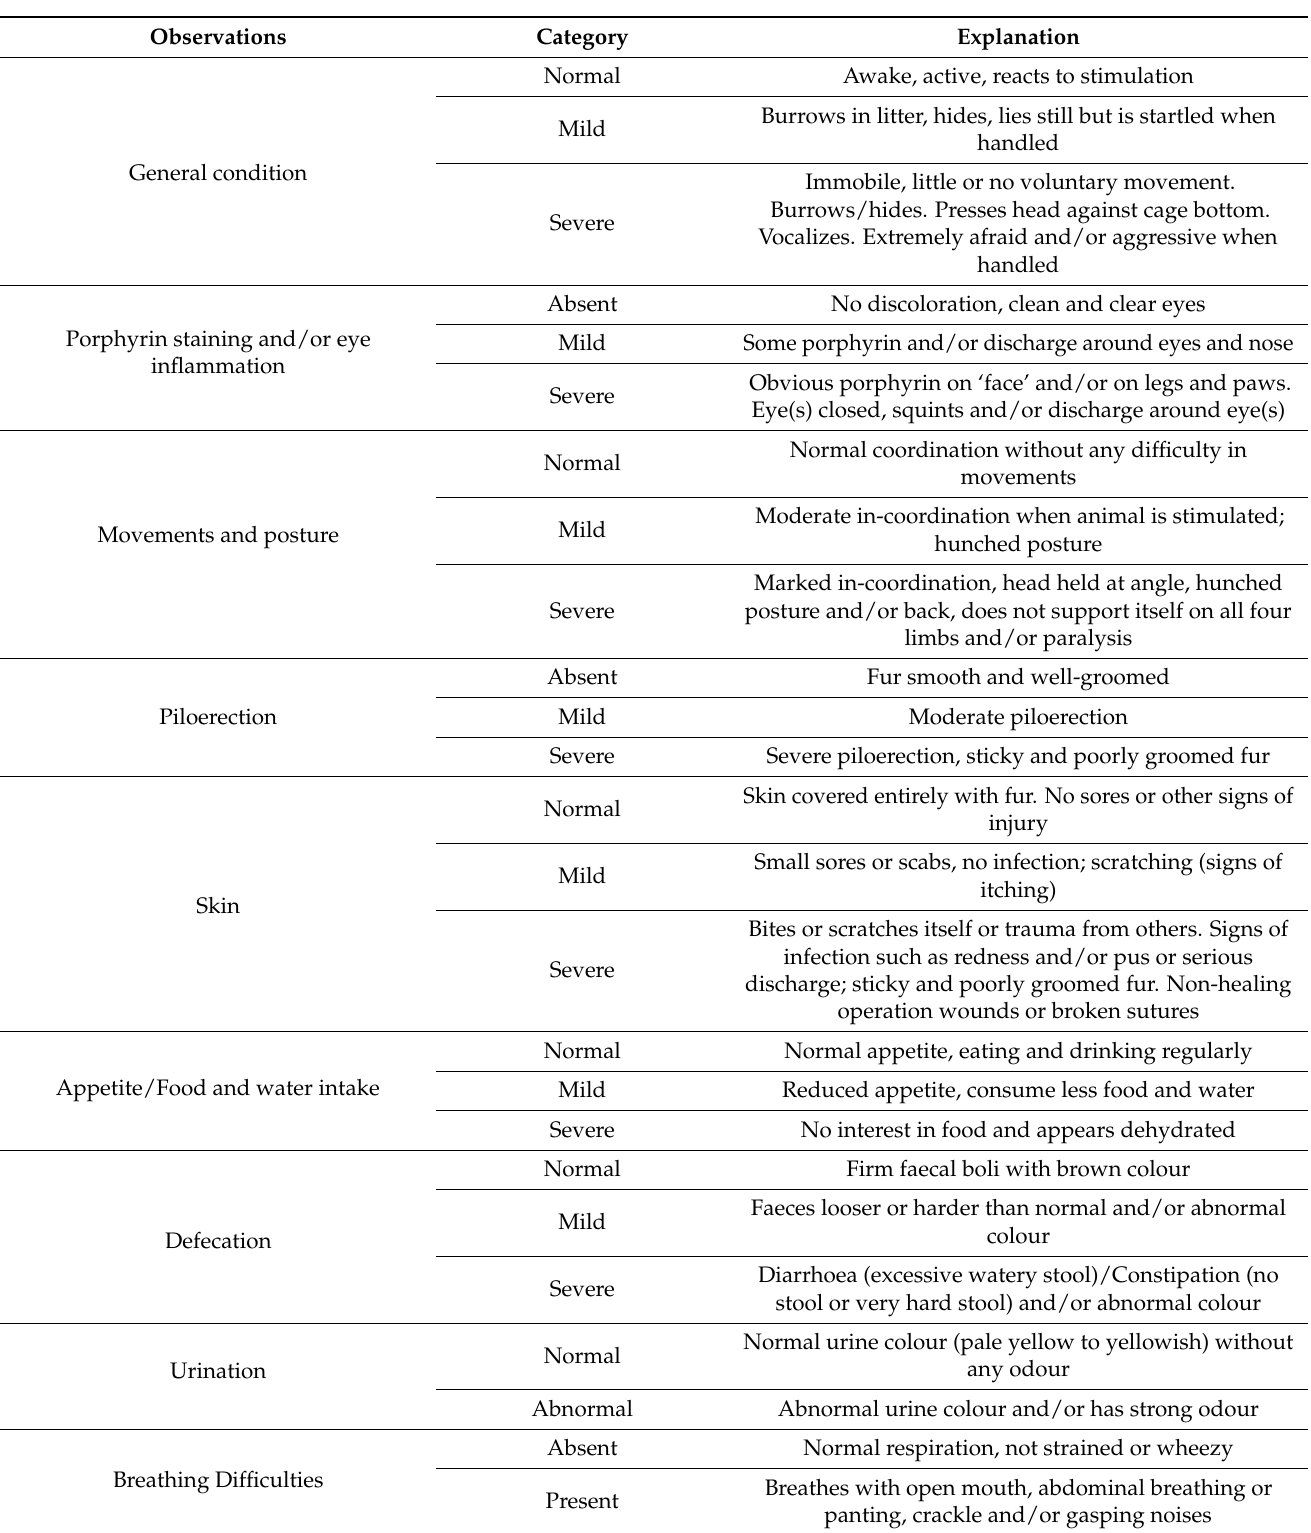
Table 1. Cage-side observation